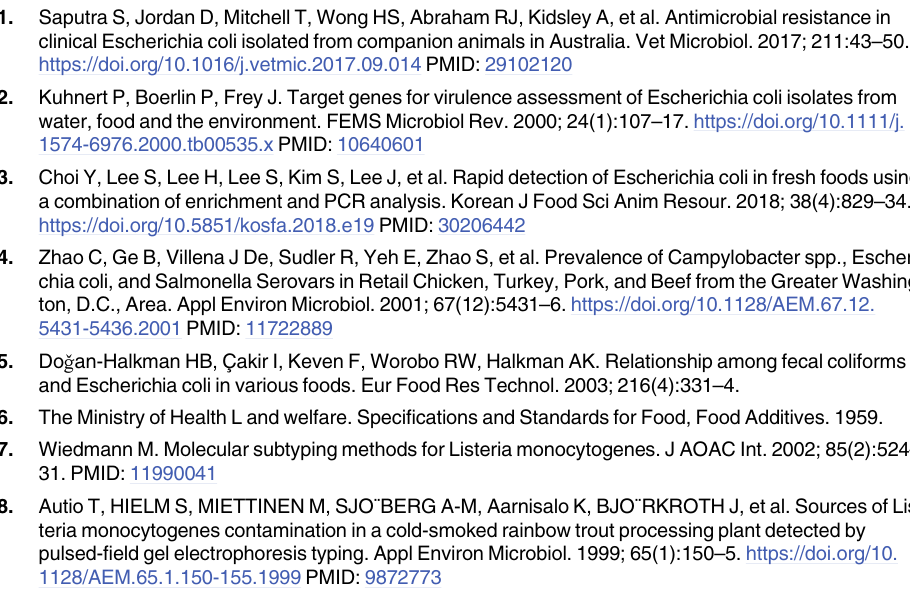
S1 Table. The result of assembly using